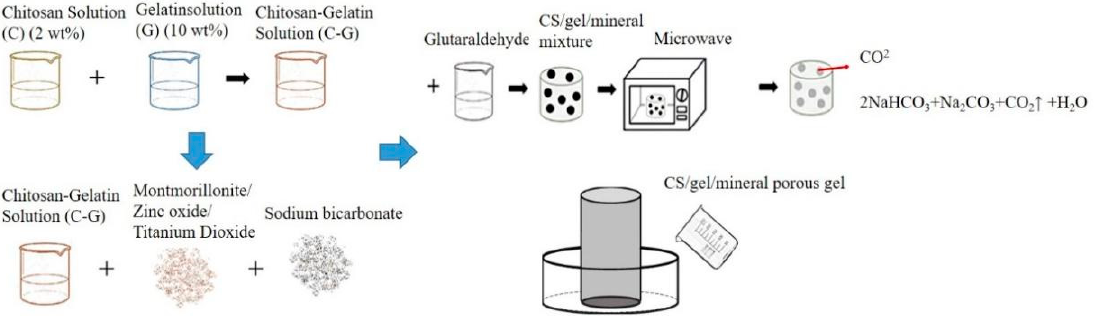
Figure 1. Processing flow chart of CS/gel/mineral porous gel and schematic of self-made mold for bone scaffolds.